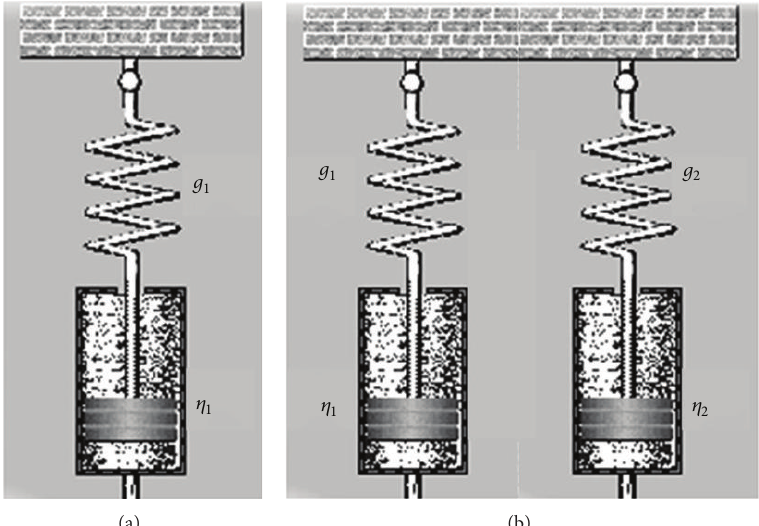
Figure 39: The schematics of the (a) single mode Maxwell and (b) 𝑁 -modes ( 𝑁 = 2 ) Maxwell model. Note that 𝑔 𝑖 is the spring constant and 𝜂 𝑖 is the viscosity of the dash pot.